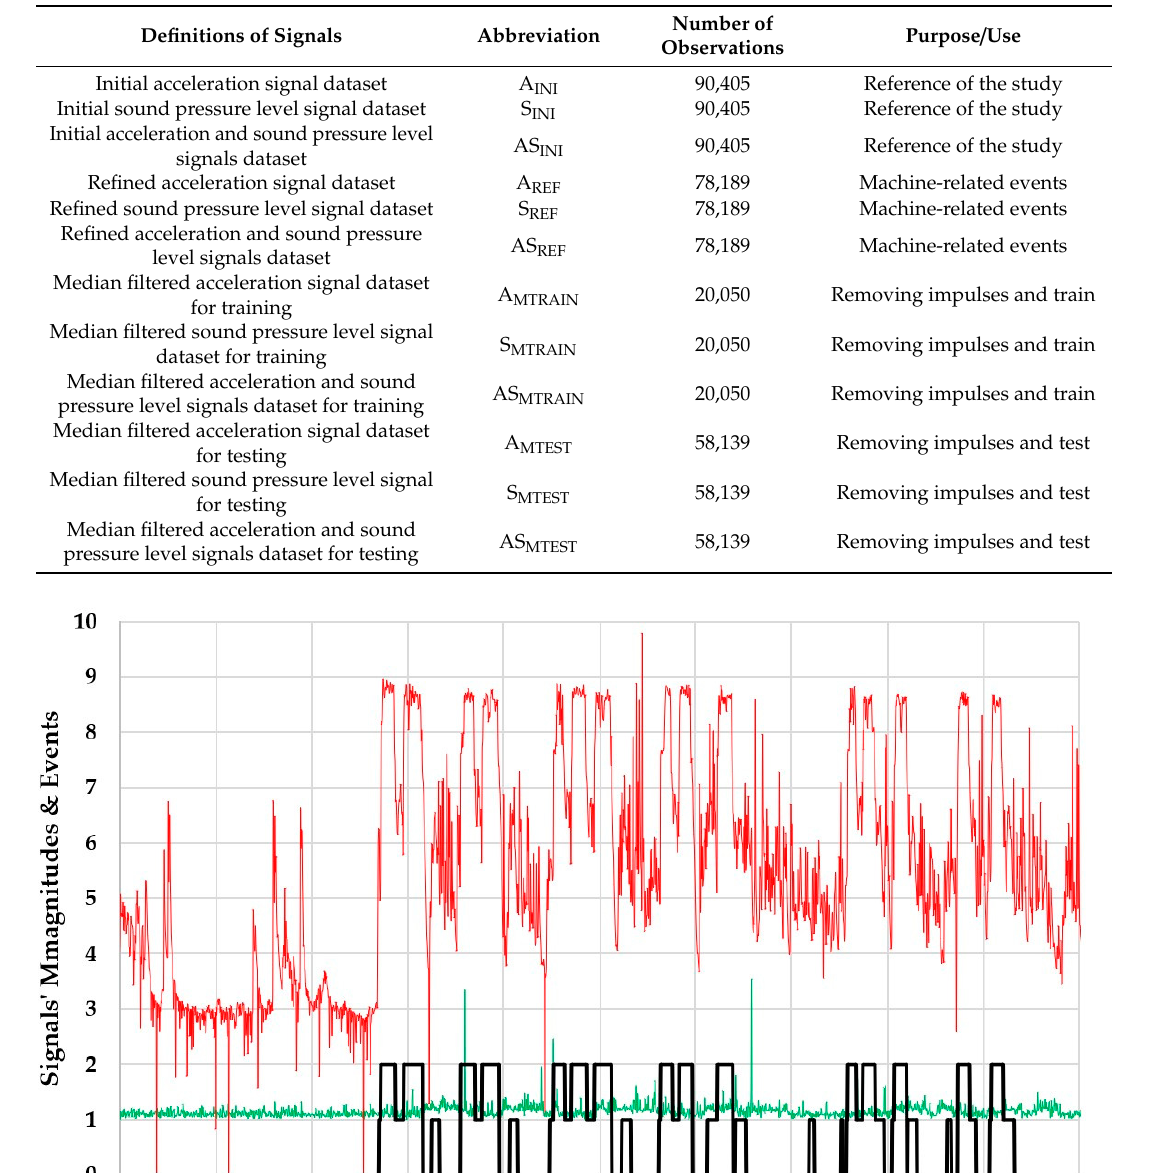
Table 1. Description of the initial, refined and median filtered input signal data.